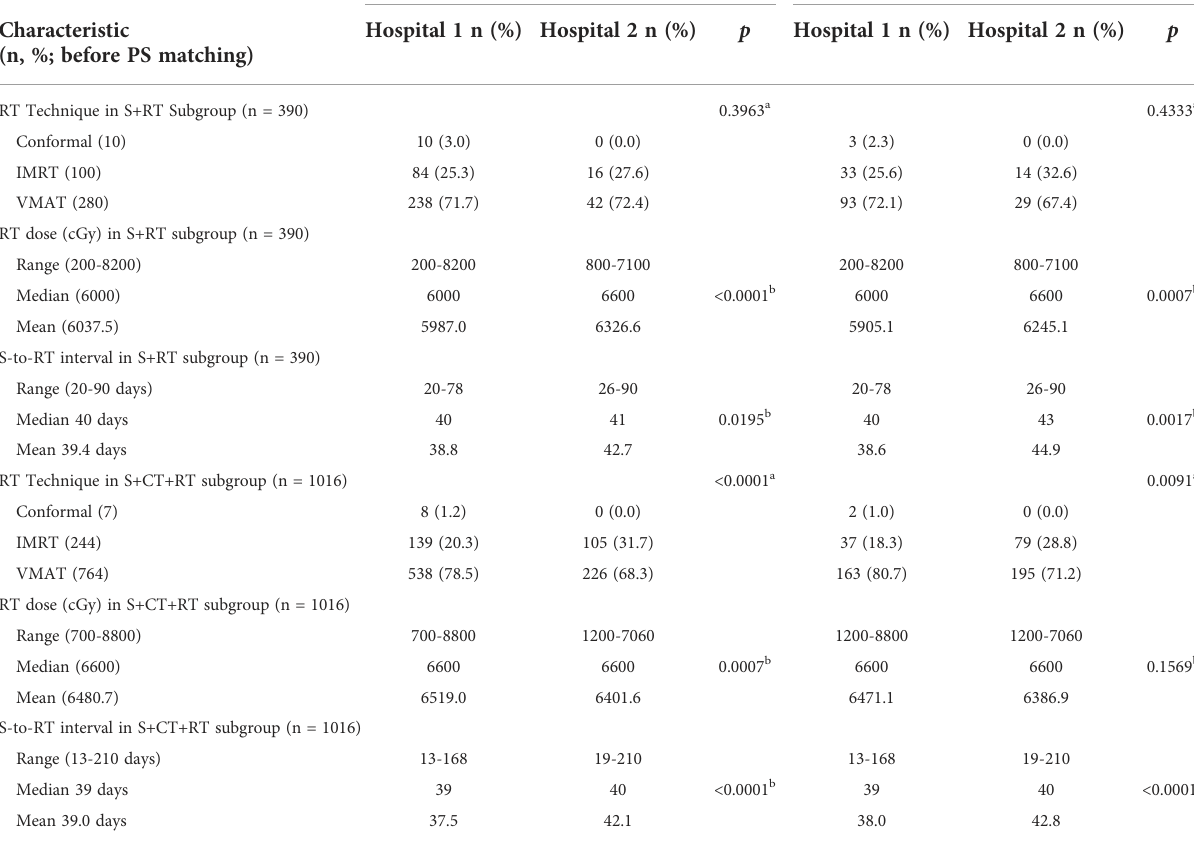
TABLE 2 General characteristics of patients with oral cavity squamous cell carcinoma receiving adjuvant radiotherapy therapy enrolled from Hospital 1 and Hospital 2 before (n = 1406) and after (n = 648) propensity score matching. Before PS matching After PS matching